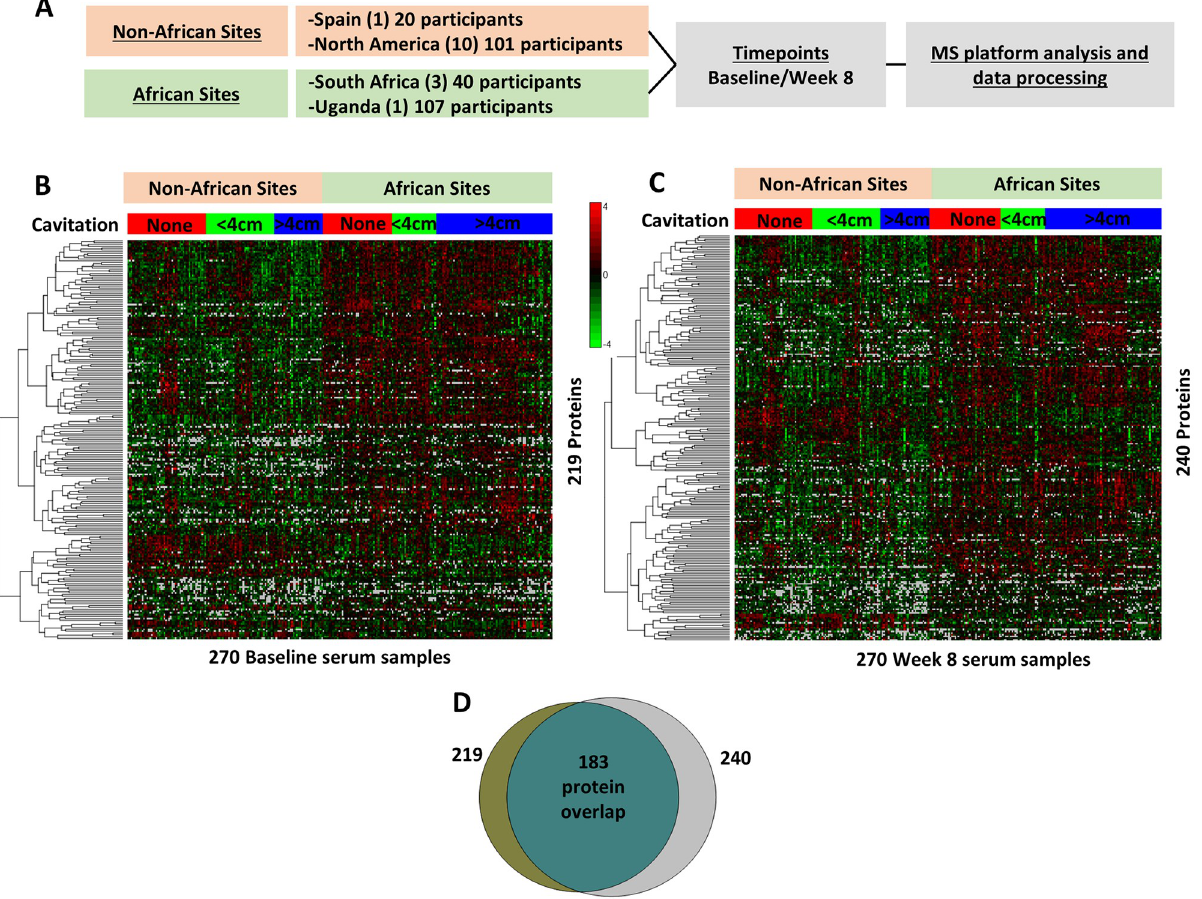
Fig 1. Comparison of African and non-African serum plasma proteome data. A) Schematic view of study sites and participants. Serum proteome data was compared at B) baseline and C) after eight weeks of treatment across 270 patients to determine the significant proteins, p value < 0.05, that differentiate African versus Non-African patients. Disease severity is representing by stratification by cavitary size. 219 and 240 proteins were identified respectively from these time points which resulted in an overlap of D) 183 proteins, which forms a core protein signature of African/Non-African differentiation independent of